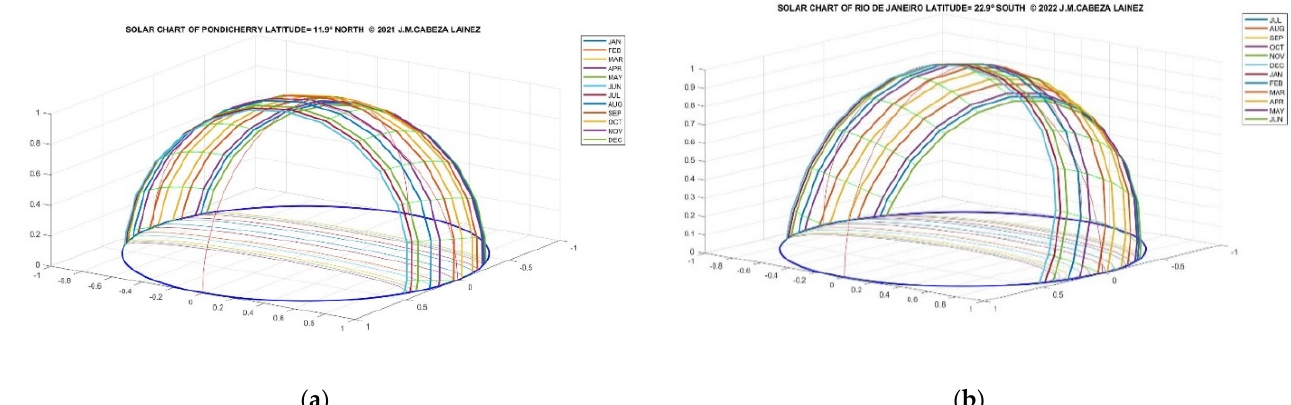
Figure 12. Comparison of 3D solar trajectories ( a ) Golconde Ashram. ( b ) Ministry of Health.